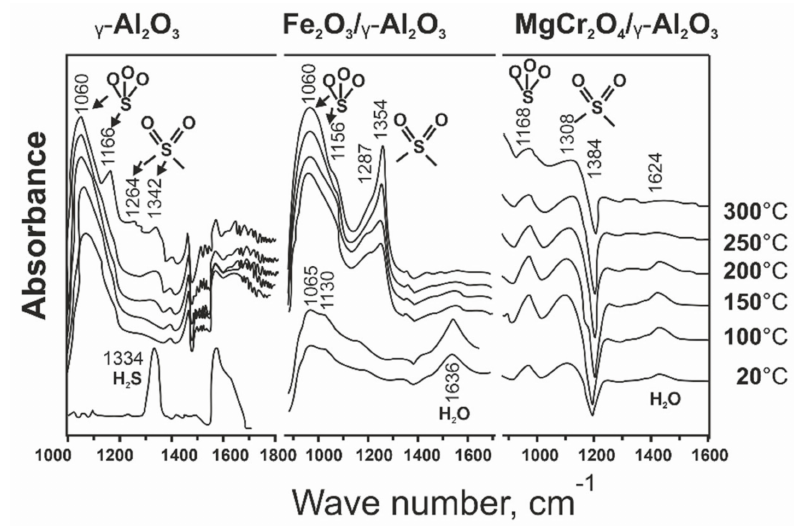
Figure 11. IR spectra of samples of different catalysts after adsorption of 20 torr of H 2 S at various temperatures.